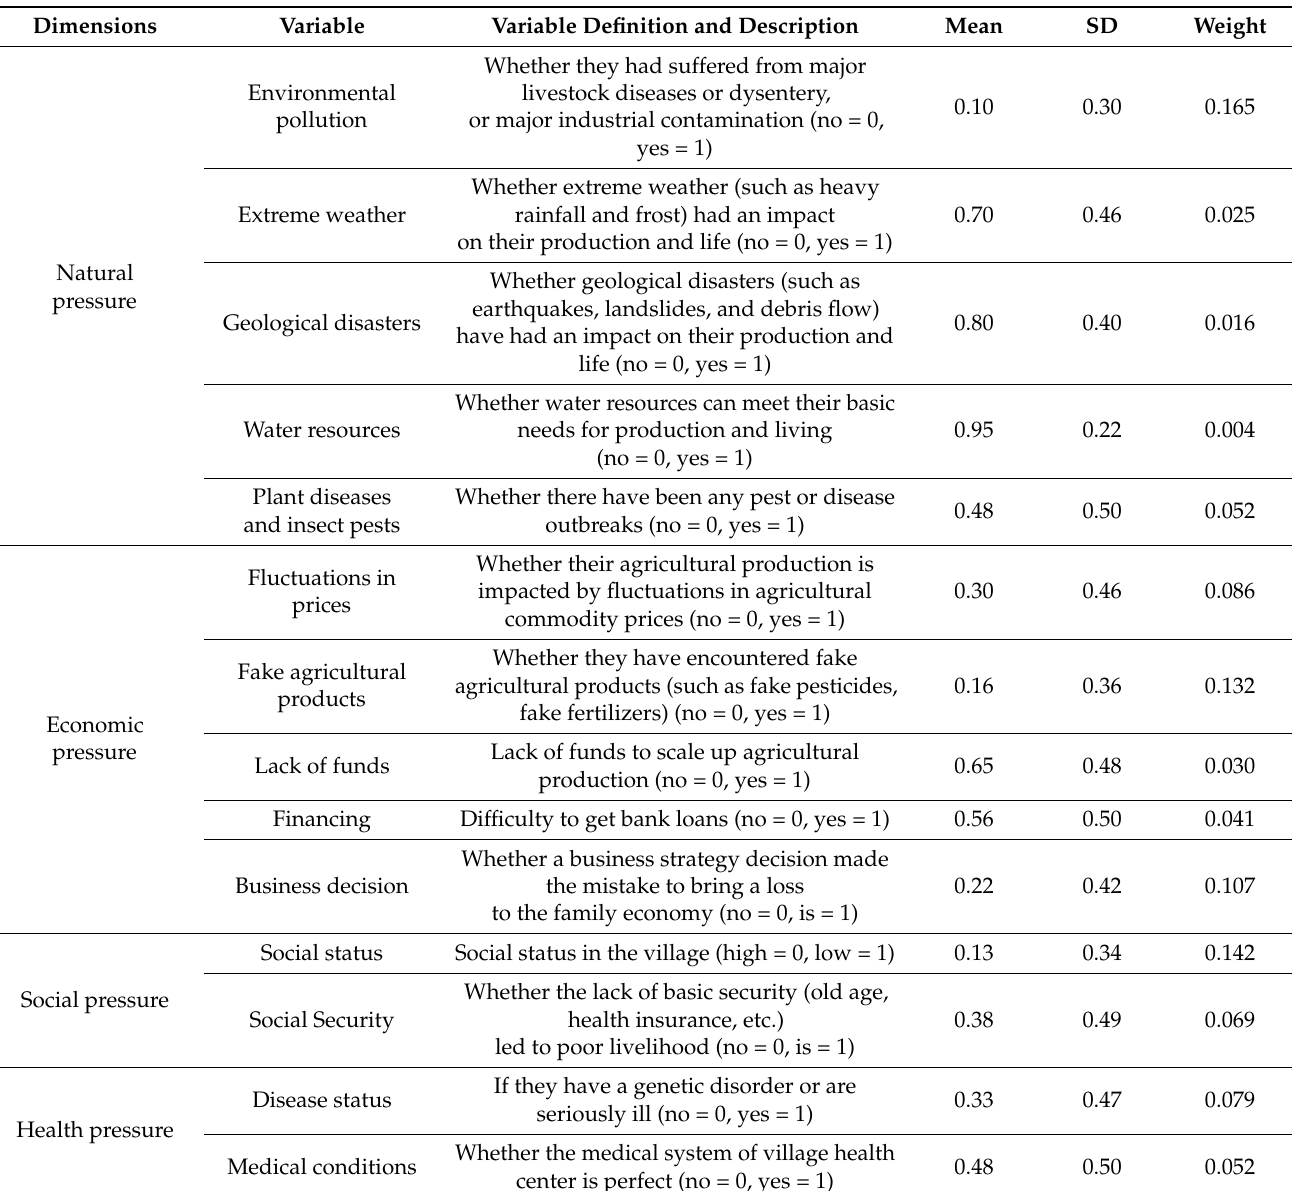
Table 1. Evaluation index system of farmer households’ livelihood